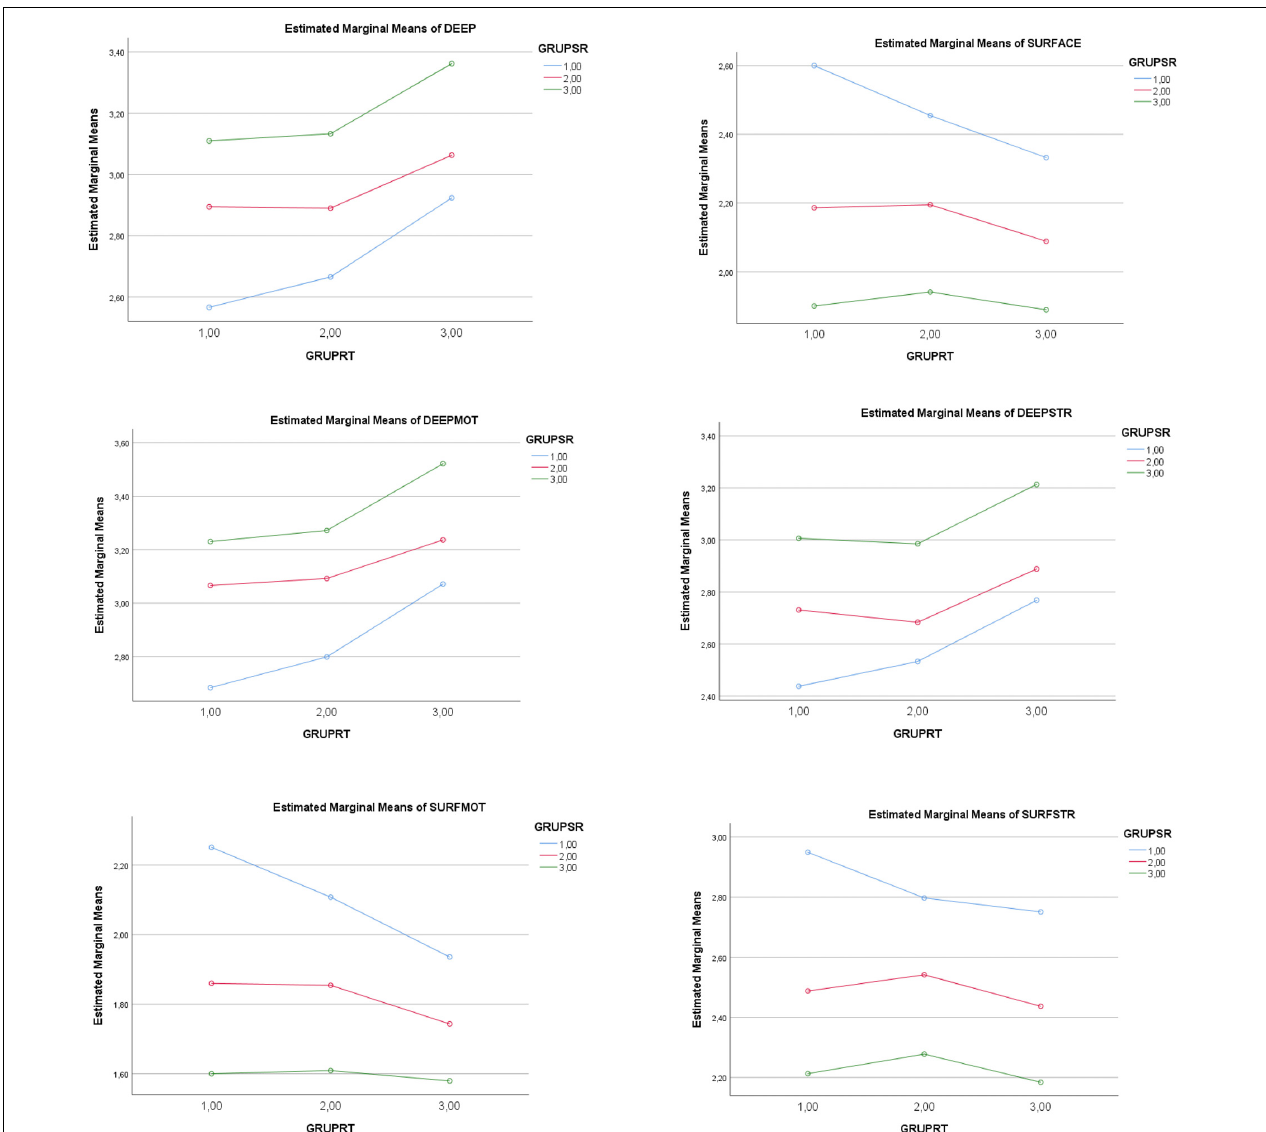
FIGURE 1 | Graphic representation of the effect of levels in the IV Self-Regulation (GRUPSR: Low = 1; Medium = 2; High = 3) and level in the IV Regulatory Teaching (GRUPRT: Low = 1; Medium = 2; High = 3) on Learning Approaches (LA). DEEP, Deep approach; SURFACE, Surface approach; DEEPMOT, Deep motivation; DEEPSTRAT, Deep strategies; SURFMOT, Surface motivation; SURFSTRAT, Surface strategies.